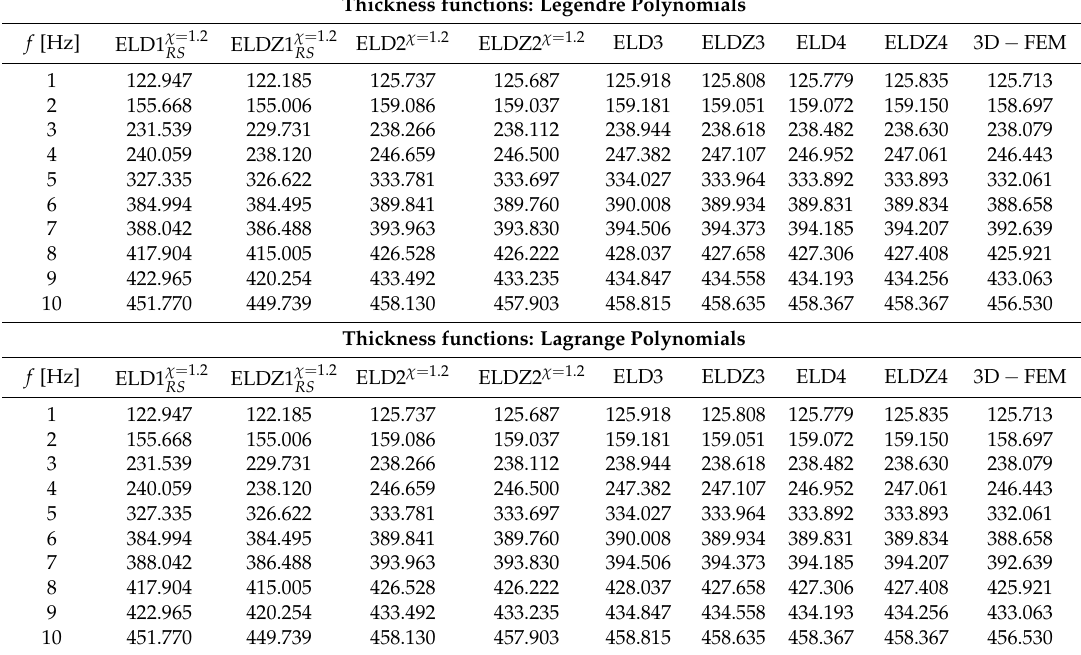
Table 9. First 10 natural frequencies ([Hz]) for a CFCF (clamped-free-clamped-free) laminated panel of translation with ( 0/30/60/90 ) as lamination scheme for several higher-order ELW approaches, with and without the Murakami’s function. The Cheb-Gau-Lob grid distribution is used for the numerical solution assuming I N = 35 and I M = 25.